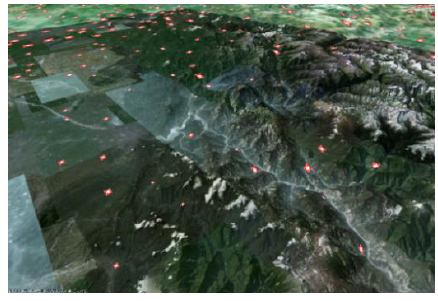
Figure 9. The fusion of hospital's point data